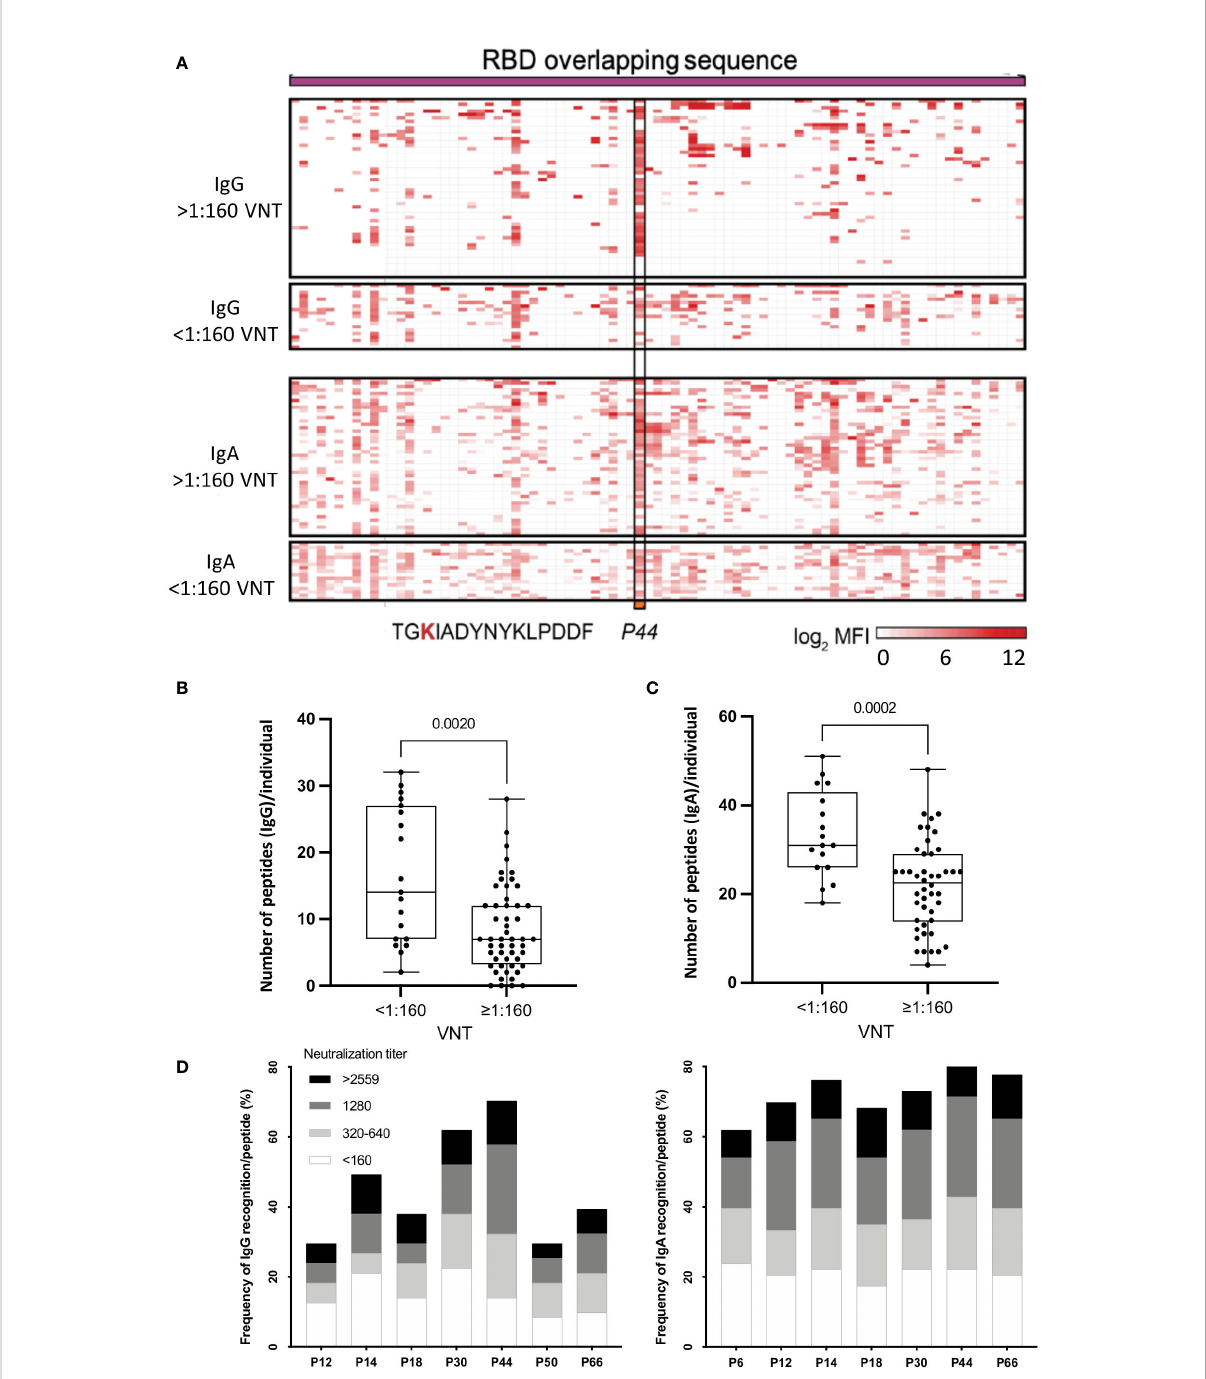
FIGURE 1 (A) Heatmap representing the magnitude of recognition of SARS-CoV-2 RBD peptides tested for IgG and IgA reactivity using a peptide microarray (columns: ordered by the primary structure sequence) for all convalescents (rows: grouped by antibody isotype and level of neutralizing activity tested in the same samples, and clustered using median values within each group). Highlighted is peptide P44 (S 415-429 ) and its respective amino acid sequence. High: individuals displaying serum with high neutralizing activity ( ≥ 1:160), Low: individuals displaying serum with low neutralizing activity (<1:160). MFI: mean fl uorescence intensity. (B) Number of peptides recognized per individual considering high and low VNT for IgG and IgA (C, D) Selected immunodominant peptides recognized by IgG ( P12, P14, P18, P30, P44, P50 and P66) and IgA ( P6, P12, P14, P18, P30, P44 and P66) , of at least 30% of the individuals in the cohort (n=71) are represented with their total percentage of recognition and neutralization titers ranges. P6: peptide 6 (S 353-367 ), P12: peptide 12 (S 365-379 ), P14: peptide 14 (S 370-384 ) and P18: peptide 18 (S 378-392 ), P30: peptide 30 (S 397-401 ), P44: peptide 44 (S 415-429 ), P50: peptide 50 (S 427-441 ) and P66: peptide 66 (S 459-473